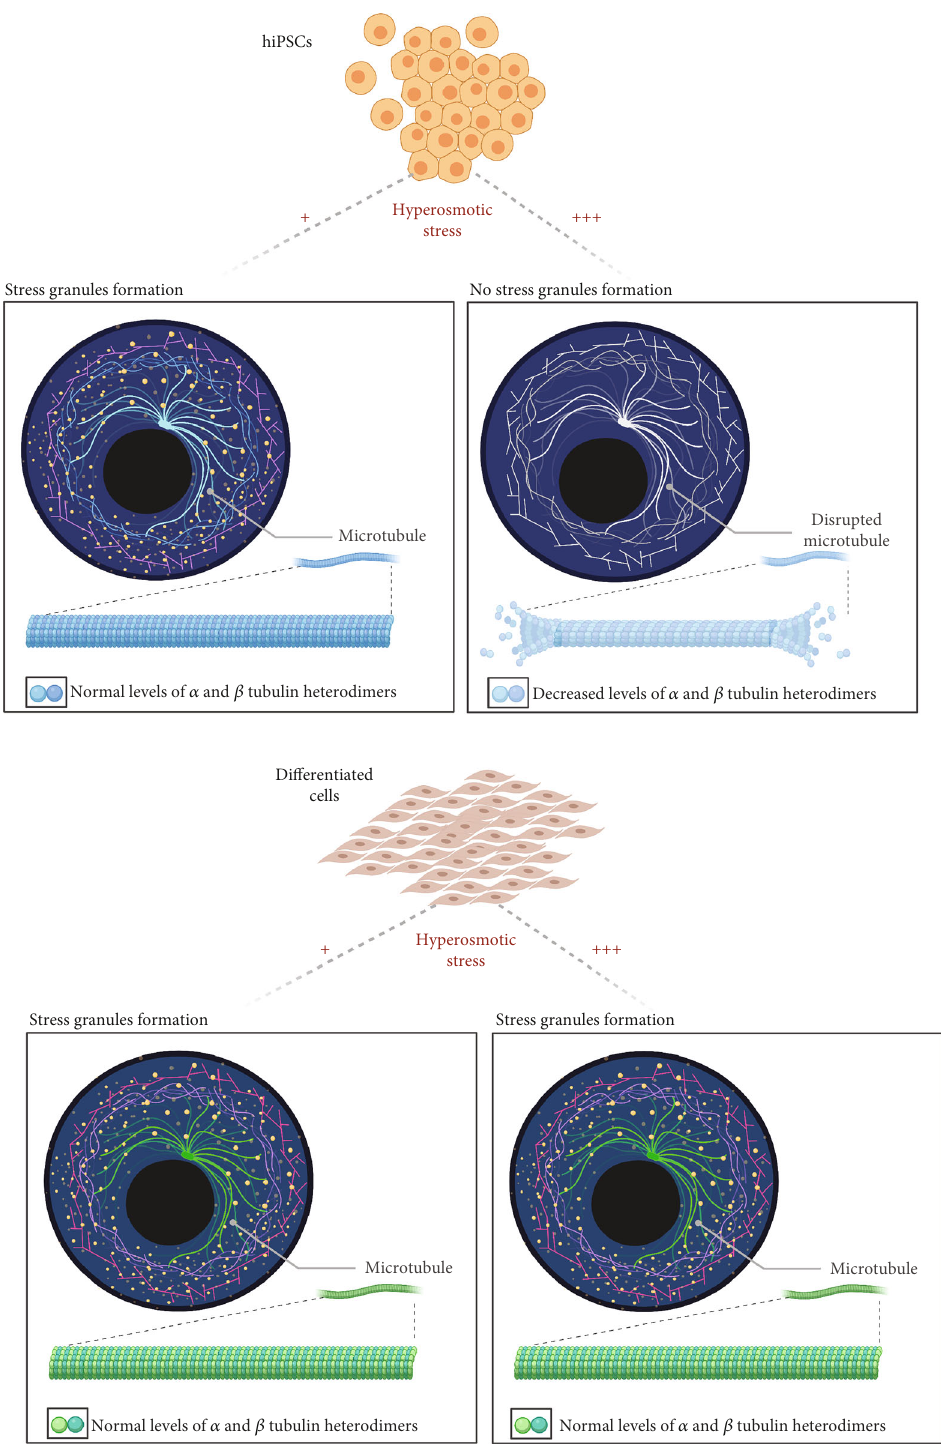
Figure 7: The summary fi gure of the study. This summarizes a cellular mechanism that controls the assembly and disassembly of SGs induced by hyperosmotic stress in hiPSCs/IMR90-1. Upon gradient concentrations of hyperosmolarity treatment, the e ff ect of increased cell osmolarity di ff ers from one type of cell to another. Under 200mM of NaCl, hiPSCs/IMR90-1 and SH-SY5Y showed SG formation. However, with a higher concentration, 400mM, SGs disappeared in hiPSCs/IMR90-1. Reduced expression of tubulin may protect cells against hyperosmolarity stress while inhibiting SG formation without a ff ecting stem cell self-renewal and pluripotency. Possible implications of microtubule organization, dynamic structural cellular components, on the response to hypertonic stress in hiPSCs were